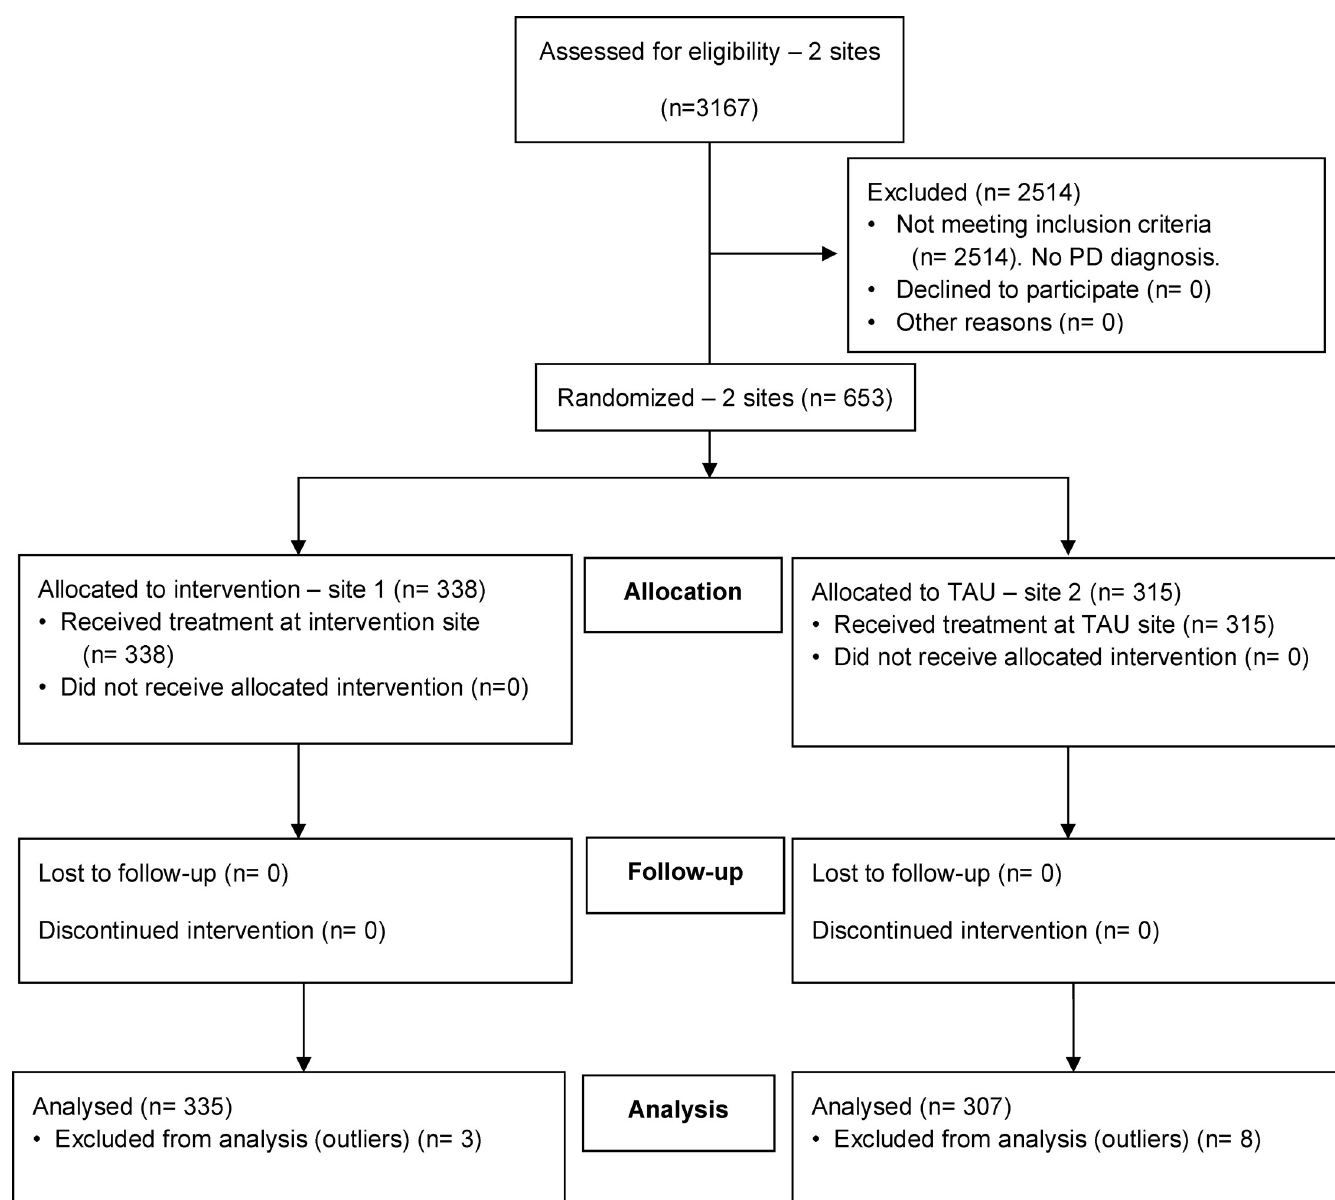
Fig 1. CONSORT flow diagram of patients with personality disorder in a study of hospital